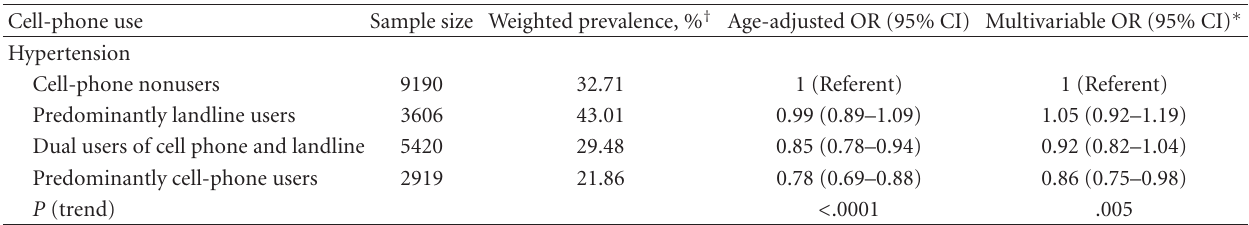
Table 2: Association between cell-phone use and